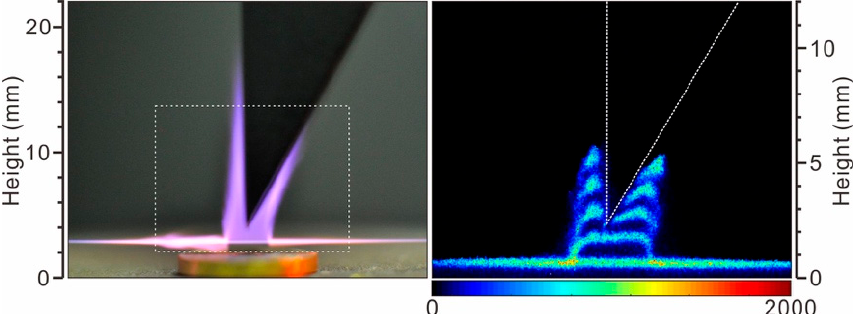
Figure 9. Following the movement of femtosecond laser-induced cyano chemiluminescence (FLICC) signal using a single lens reflex camera ( left ) and an ICCD camera in the on-chip multi-exposure mode ( right ).